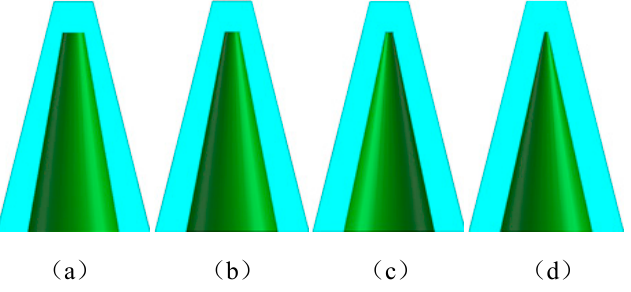
Figure 4. The change of the outer dimensions of the mold with the use of time ( a ) initial state ( b ) wear after a short period of use ( c ) wear after a longer period of use ( d ) failure state